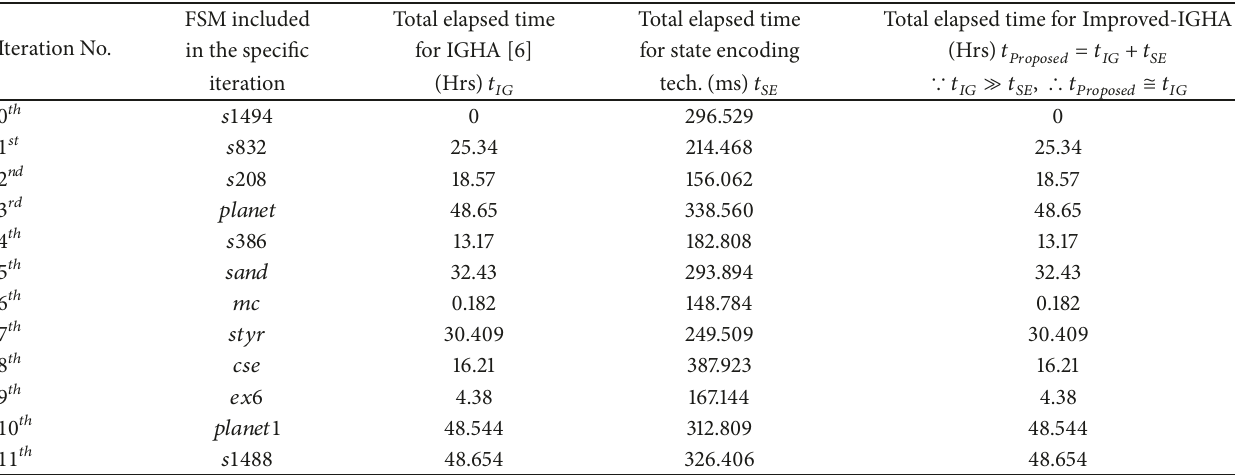
Table 8: Comparative analysis of the total computation time required by IGHA [6] and Improved-IGHA. FSM included Total elapsed time Total elapsed time Total elapsed time for Improved-IGHA Iteration No. in the specific for IGHA [6] for state